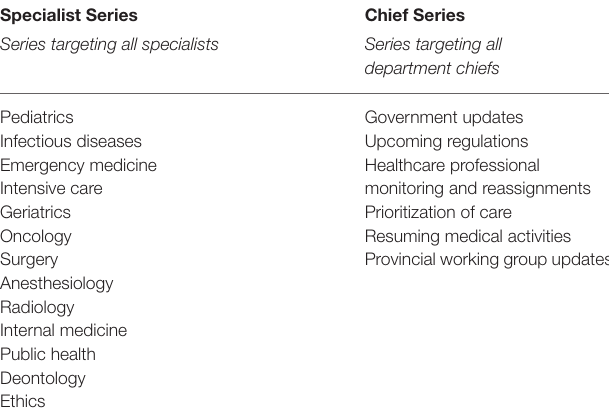
Frontiers in Medicine |